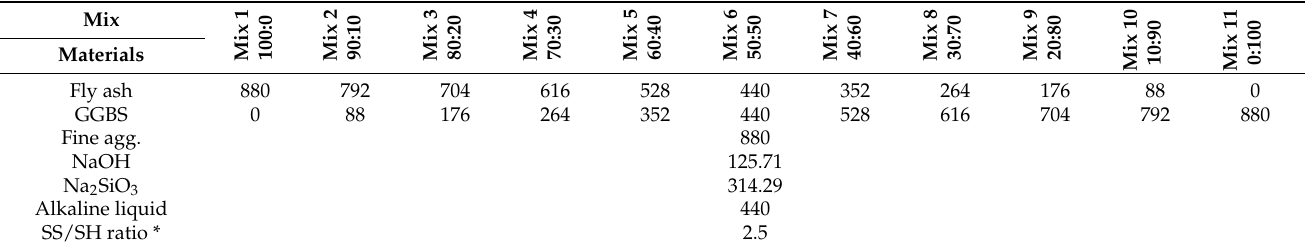
Table 6. Detailed mix proportion to cast specimens in kg/m 3